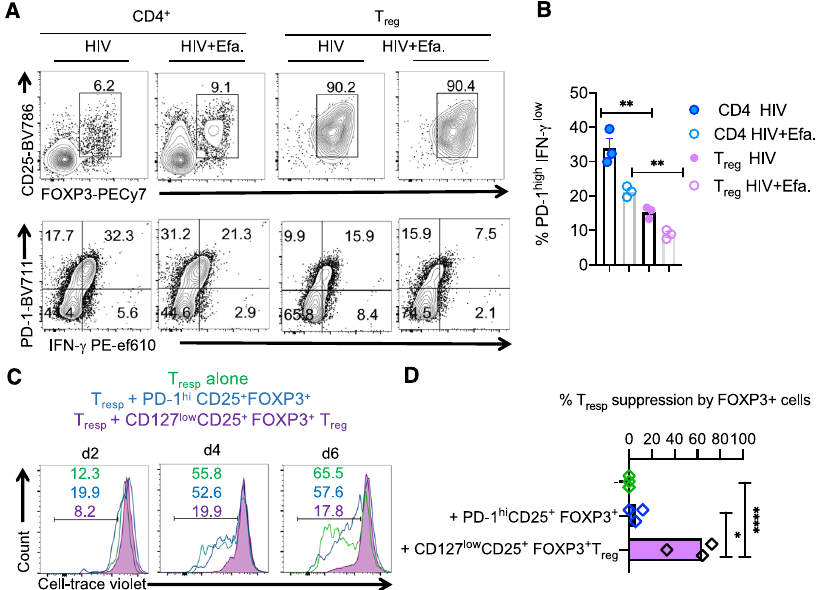
Fig. 7 PD-1 + FOXP3 + cells from HIV-infected cultures have little or no suppressive activity. Puri fi ed CD4 + T cells and T regs were stimulated and infected as in “ Methods. ” A CD25 and FOXP3 expression in all cells in the cultures (above) and PD-1 and IFN- γ expression in CD25 + FOXP3 + cells (below) at 96 h post infection. B Statistical analyses of PD-1 hi IFN- γ + cells in FOXP3 + population from these two cultures. C PD-1 hi CD25 + cells were puri fi ed from HIV- infected CD4 cultures using sequential sorting of PD-1-PE + cells and CD25 high T reg cells using STEMCELL technology PE isolation and CD25 + T reg isolation kits and were used in co-cultures with cell-trace violet-labeled responder T cells (T resp ) at ratio 1:1. As controls, T resp cells were cultured alone or co- cultured with puri fi ed naive CD127 low CD25 + T regs that were sequentially sorted to remove CD45RO + CD4 + cells using human CD45RO kit (Miltenyi) and purify CD25 high T reg cells using STEMCELL technology CD25 + T reg isolation kits. These control T regs were also previously stimulated and infected the same manner (purple) before co-culture with T resp . T resp proliferation was determined by cell-trace dye dilution in PD-1 hi CD25 + co-culture (blue), control T reg co-cultures (purple), or those cultured alone (green). D Statistical analyses of % T resp suppression mean values from three independent experiments showing similar results. B , D Mean + / − SEM are shown; * P < 0.05; **<0.005, ****<0.00005; two-tailed; Mann – Whitney test).